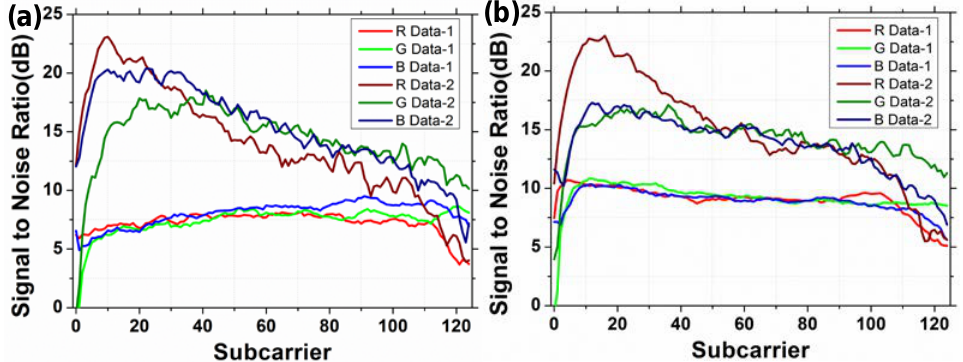
Figure 11. Experimental SNRs of the Data 1 and Data 2 over all the 125 OFDM subcarrier for R, G, and B channels in the OFDM-NOMA signals using ( a ) BPSK and ( b ) QPSK.